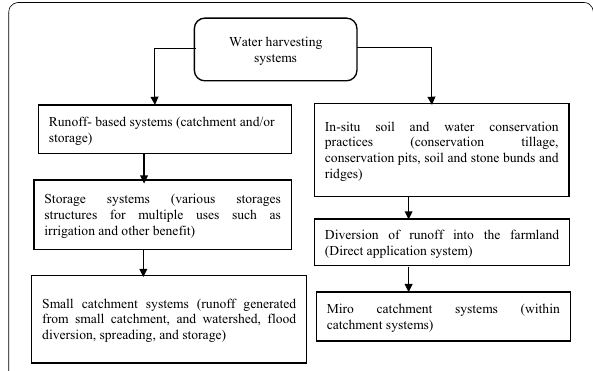
Fig. 10 Classification of water harvesting